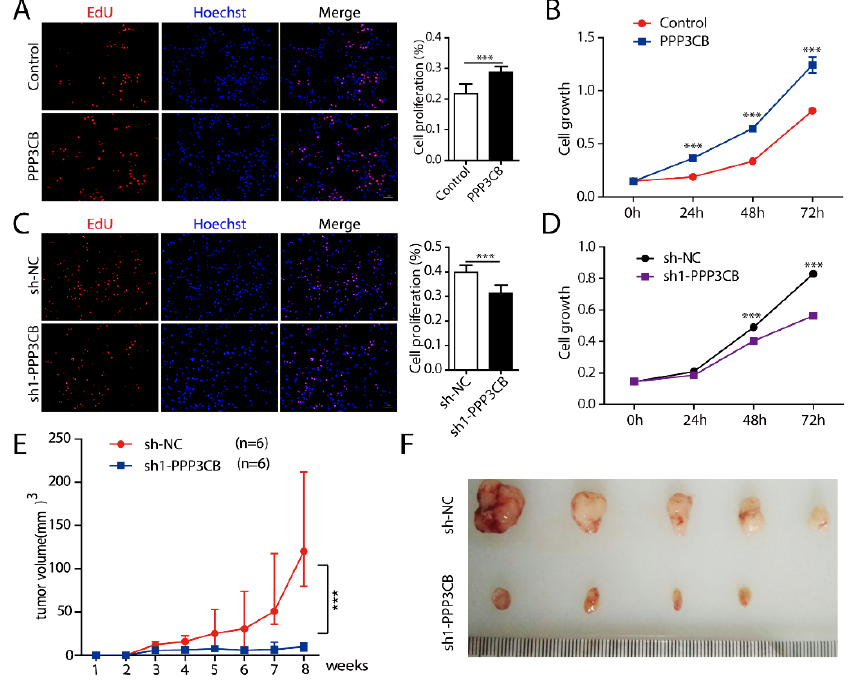
Figure 4. PPP3CB promotes G401 cell proliferation. ( A , C ) Growth of G401 stable cells was evaluated by EdU assay. Red represents EdU, blue stains nucleus, scale bar is 100 µ m. Results were expressed as mean ± SEM from three replicate wells. * p < 0.05, ** p < 0.01, and *** p < 0.001. ( B , D ) Proliferation of G401 stable cells were assessed by MTT assay. Results were expressed as mean ± SEM from eight replicate wells. * p < 0.05, ** p < 0.01, and *** p < 0.001. ( E ) Xenograft tumor growth of G401 stable cells with sh-NC or sh1-PPP3CB in nude mice. Points indicate mean values ( n = 6). * p < 0.05, ** p < 0.01, and *** p < 0.001. ( F ) Excised tumors.